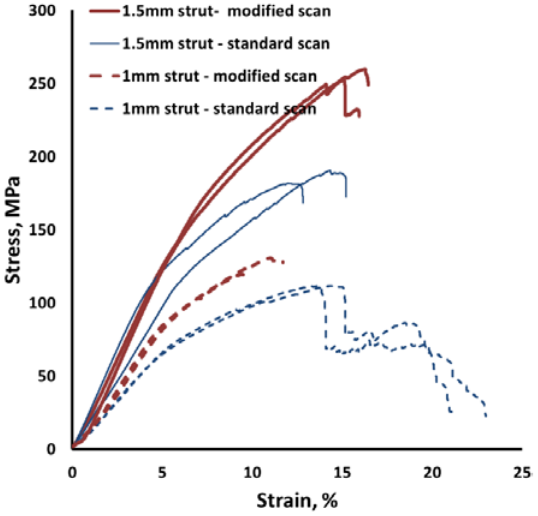
Figure 18. Effect of scan strategy on compressive properties in γ -TiAl porous structures (beam current of 18 mA).